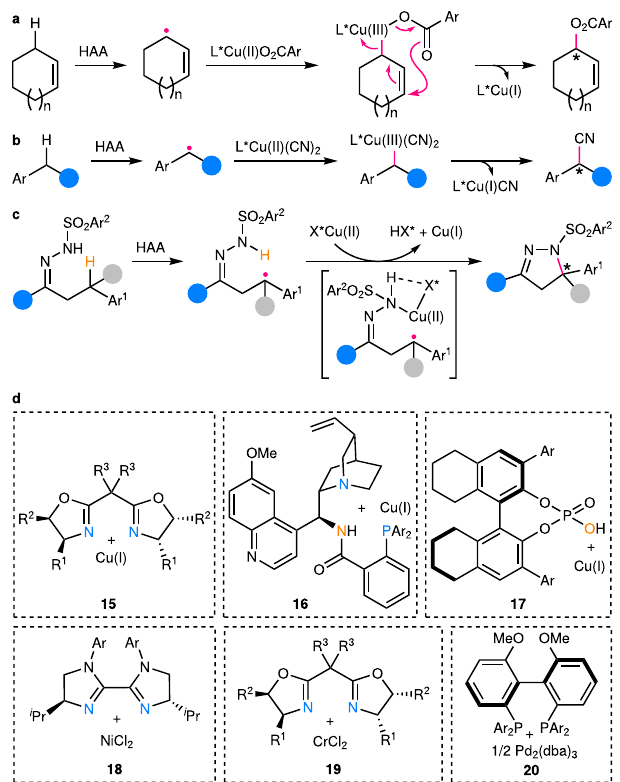
Fig. 6 Examples of enantiocontrol by chiral transition metal catalysts in enantioselective C( sp 3 ) – H functionalization. a Enantiocontrol in enantioselective Kharasch – Sosnovsky allylic C( sp 3 ) – H acyloxylation catalyzed by chiral copper complexes. b Enantiocontrol in enantioselective benzylic C( sp 3 ) – H cyanation catalyzed by copper/chiral box complexes. c Enantiocontrol in enantioselective tertiary benzylic C( sp 3 ) – H amination by copper/chiral phosphoric acid dual catalysis. d Structures of typical chiral transition metal catalysts employed in relevant works. Box